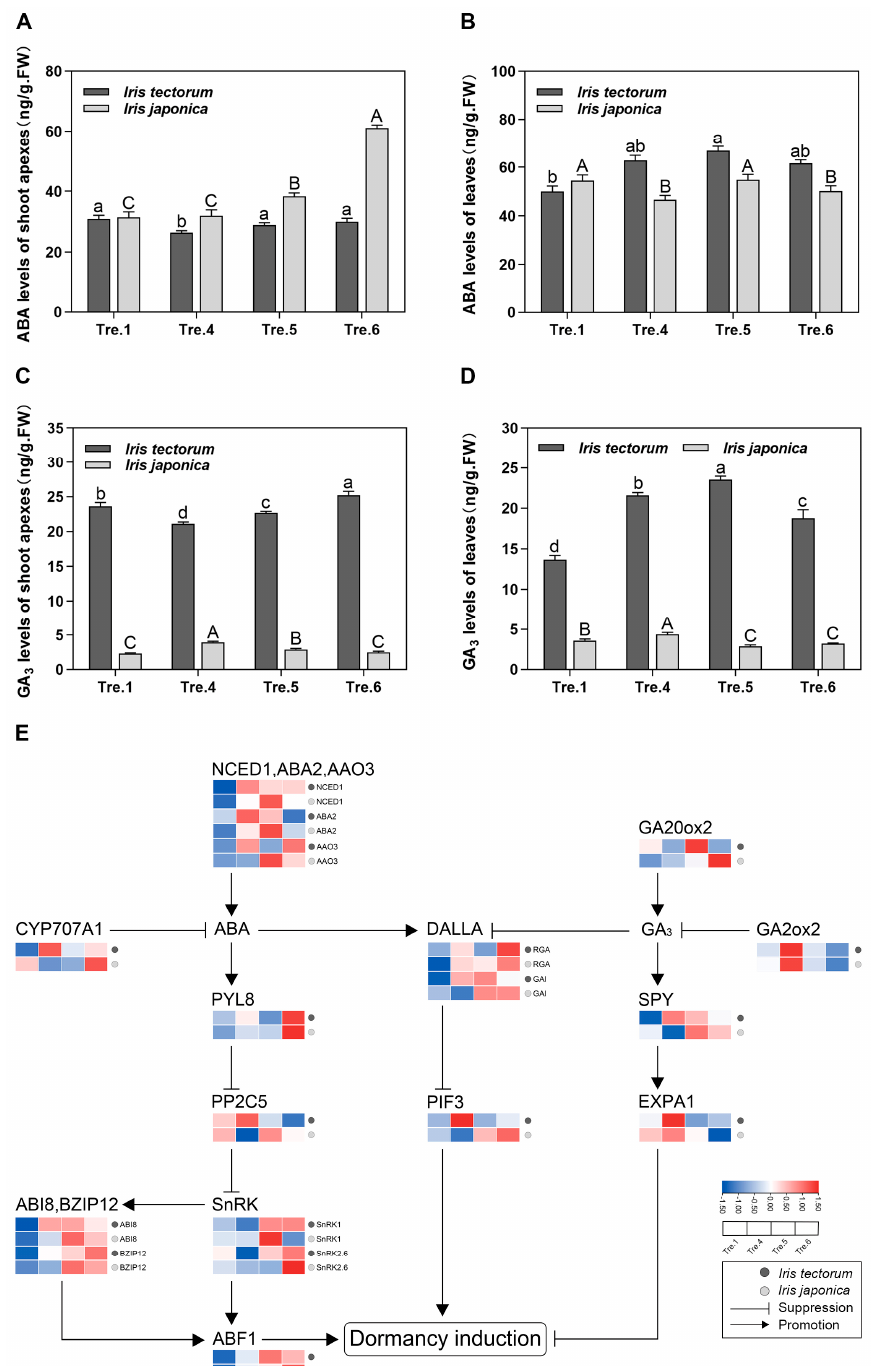
Figure 2. Changes in levels of ABA and GA 3 and transcript expression of genes associated with ABA and GA 3 pathways in Iris tectorum (IT) and I. japonica (IJ), under artificial dormancy induction conditions. ( A ) ABA level changes of shoot apexes in the two iris species. ( B ) ABA level changes of leaves in the two iris species. ( C ) GA 3 level changes of shoot apexes in the two iris species. ( D ) GA 3 level changes of leaves in the two iris species. The data in ( A – D ) are means from three biological replicates, with error bars representing standard deviation. Lowercase and uppercase letters represent significant differences for relevant parameters within IT and IJ (Duncan’s multiple comparison test p < 0.05), respectively. ( E ) Transcript expression of genes associated with ABA and GA 3 pathways in IT and IJ under artificial dormancy induction conditions. Red denotes that the gene is upregulated, whereas blue represents that the gene is downregulated. Gene full names are shown in Supplemental Table